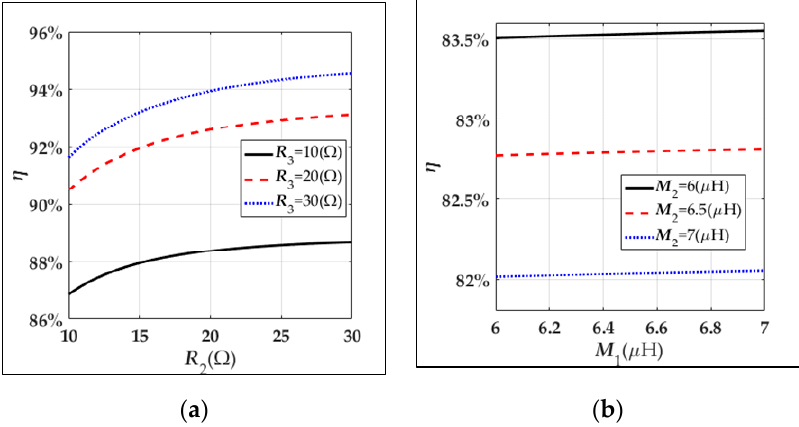
Figure 7. The variation of the efficiency η with the mutual inductances and the loads in Mode A. ( a ) The variation of η with R 2 and R 3 ; ( b ) the variation of η with M 1 and M 2 .